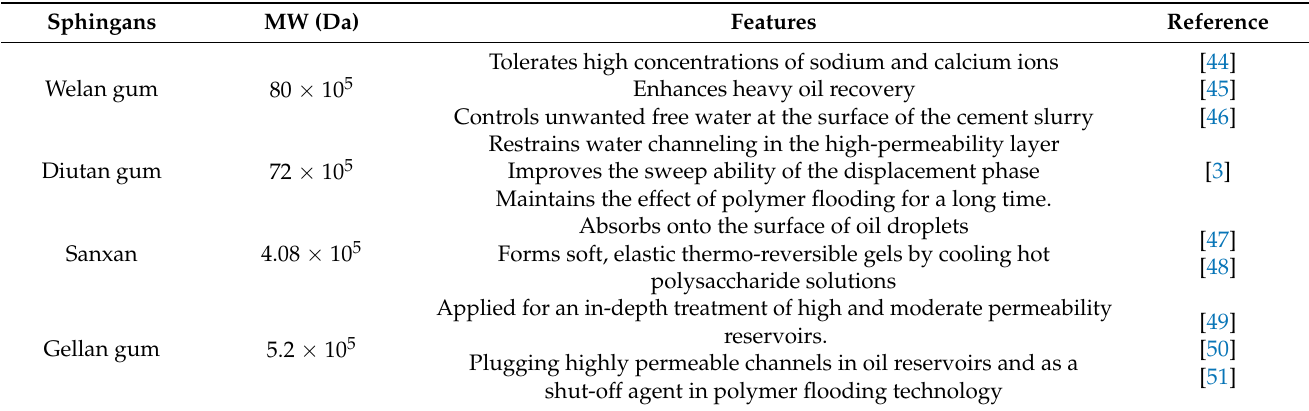
Table 2. Molecular weight and features of several